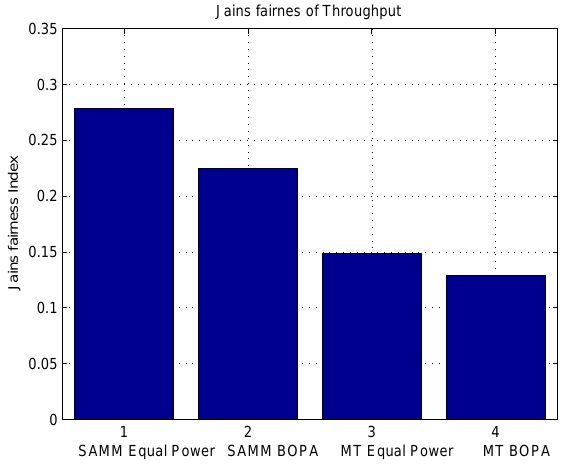
Figure 5. Jains fairness Index for